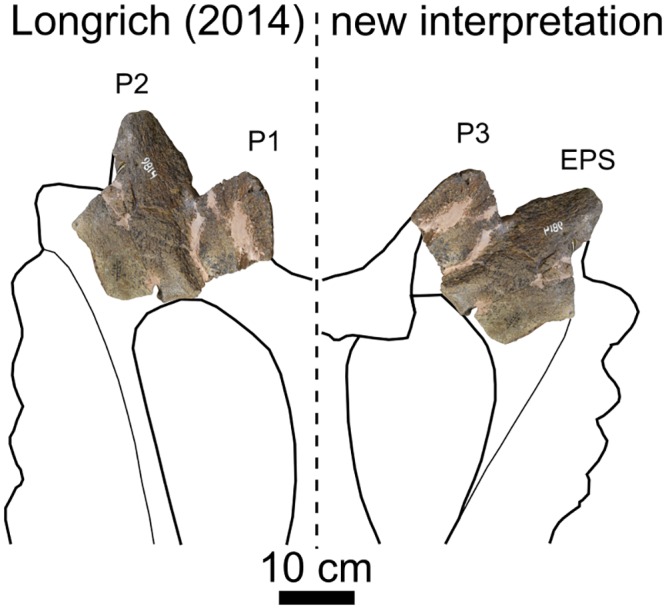
Interpretation of CMN 9813 (paratype of ‘Pentaceratops aquilonius’) in Longrich [72] (left) and the present study (right).In the right image, the specimen is mirrored about the midline to facilitate comparison. Note the differences in assumed epiossification homology. [Planned for column width].